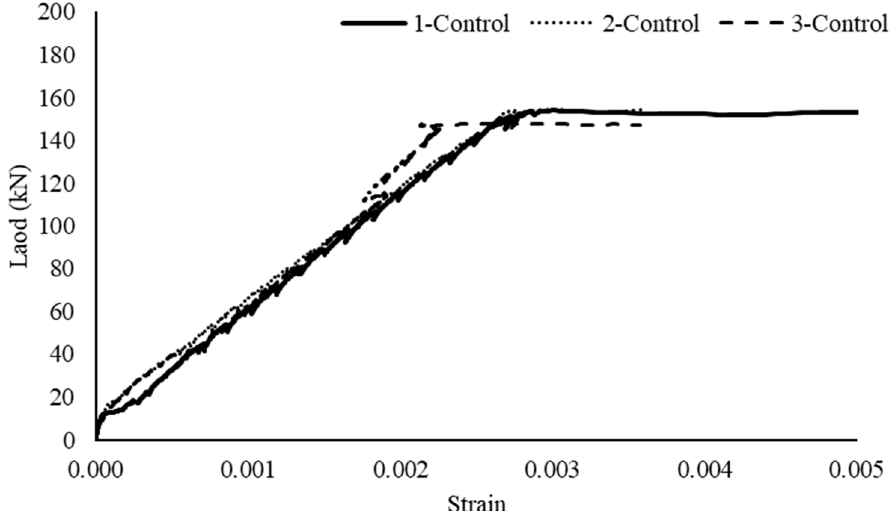
Figure 12. Load vs. strain plot for control connected girder specimens.